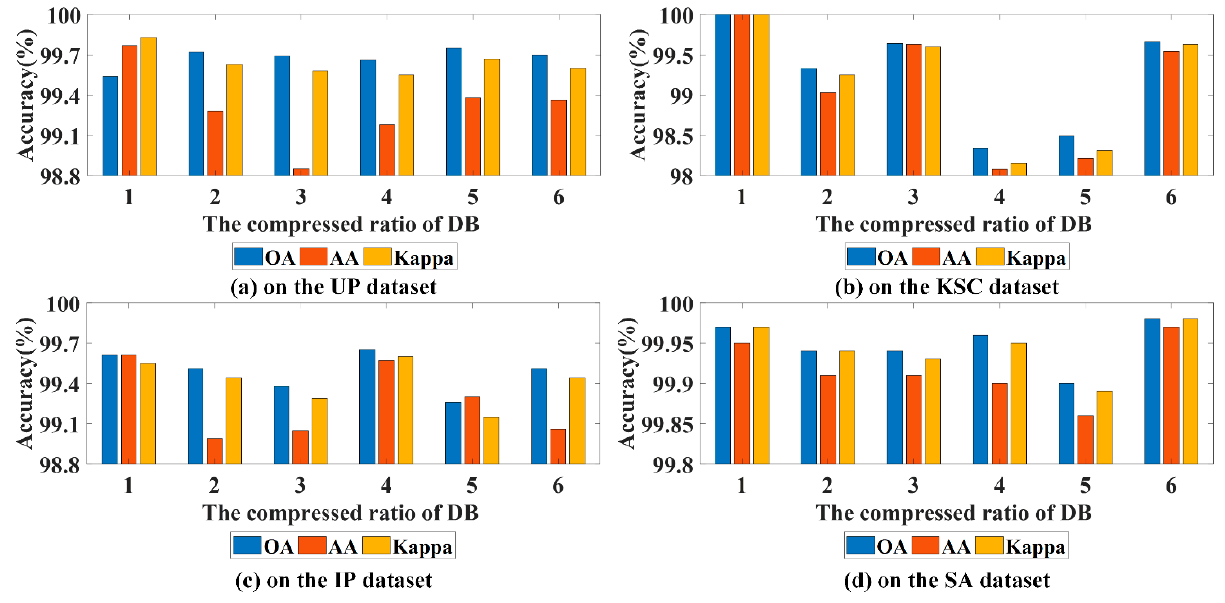
Figure 8. Three evaluation indexes for diverse compressed ratios in the DB on four experimental datasets.